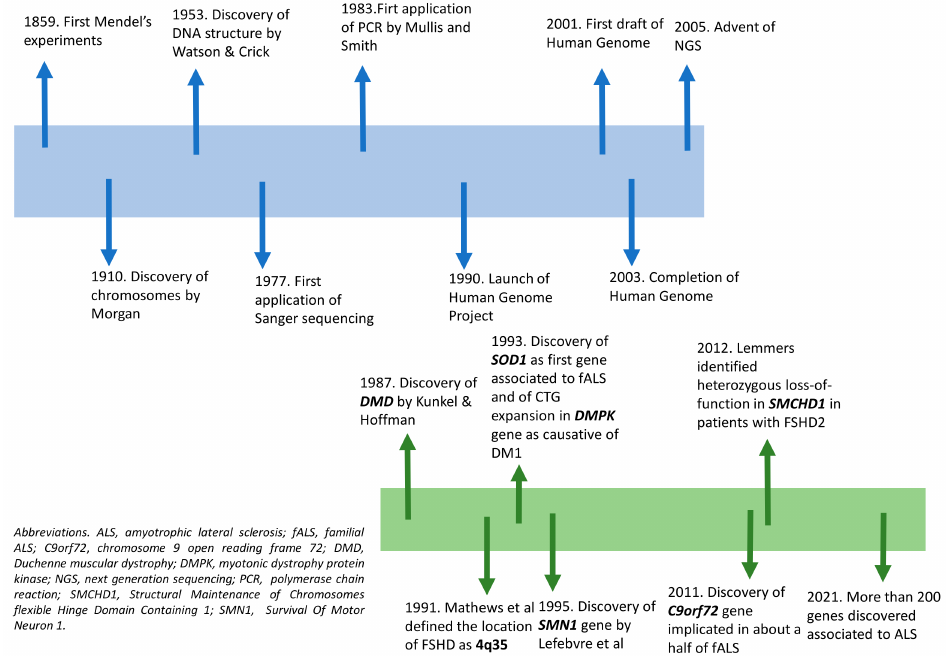
Figure 1. Timeline representing the main genetic discoveries ( top ) and the main genes discovered in Neuromuscular disorders (NMDs) ( below